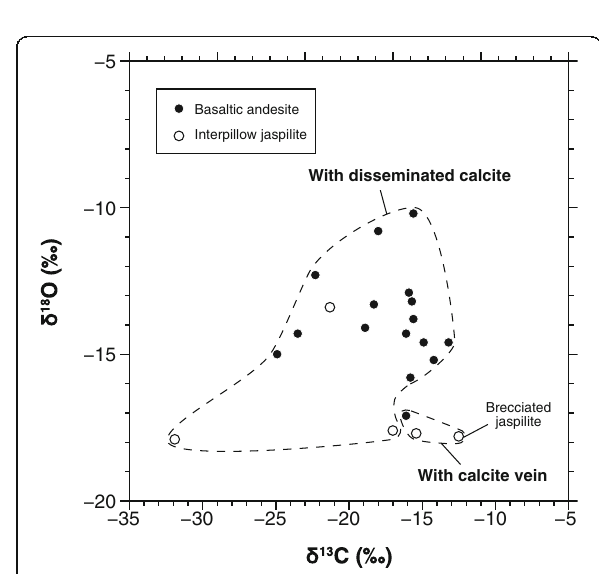
Fig. 4 Relationship between δ 18 O and δ 13 C values of the hydrothermal calcites from the Ongeluk